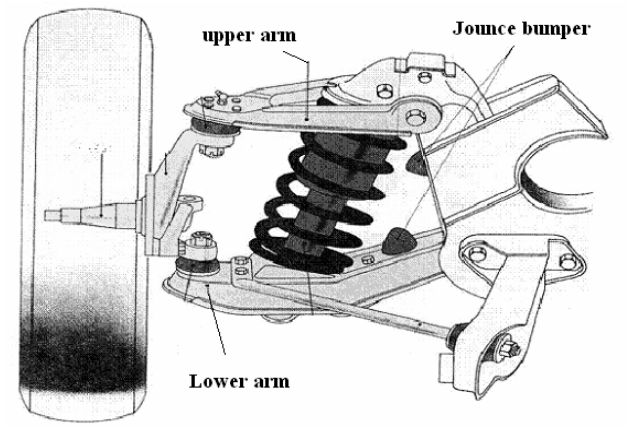
Fig. 5. Upper and lower suspension arms of a vehicle